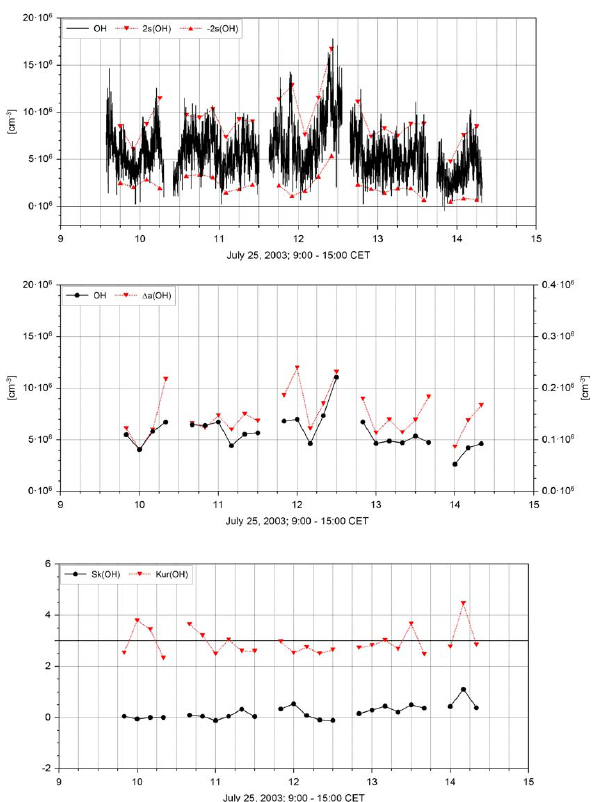
background of 31 cts/Vs (standard deviation = 2.5 cts/Vs).